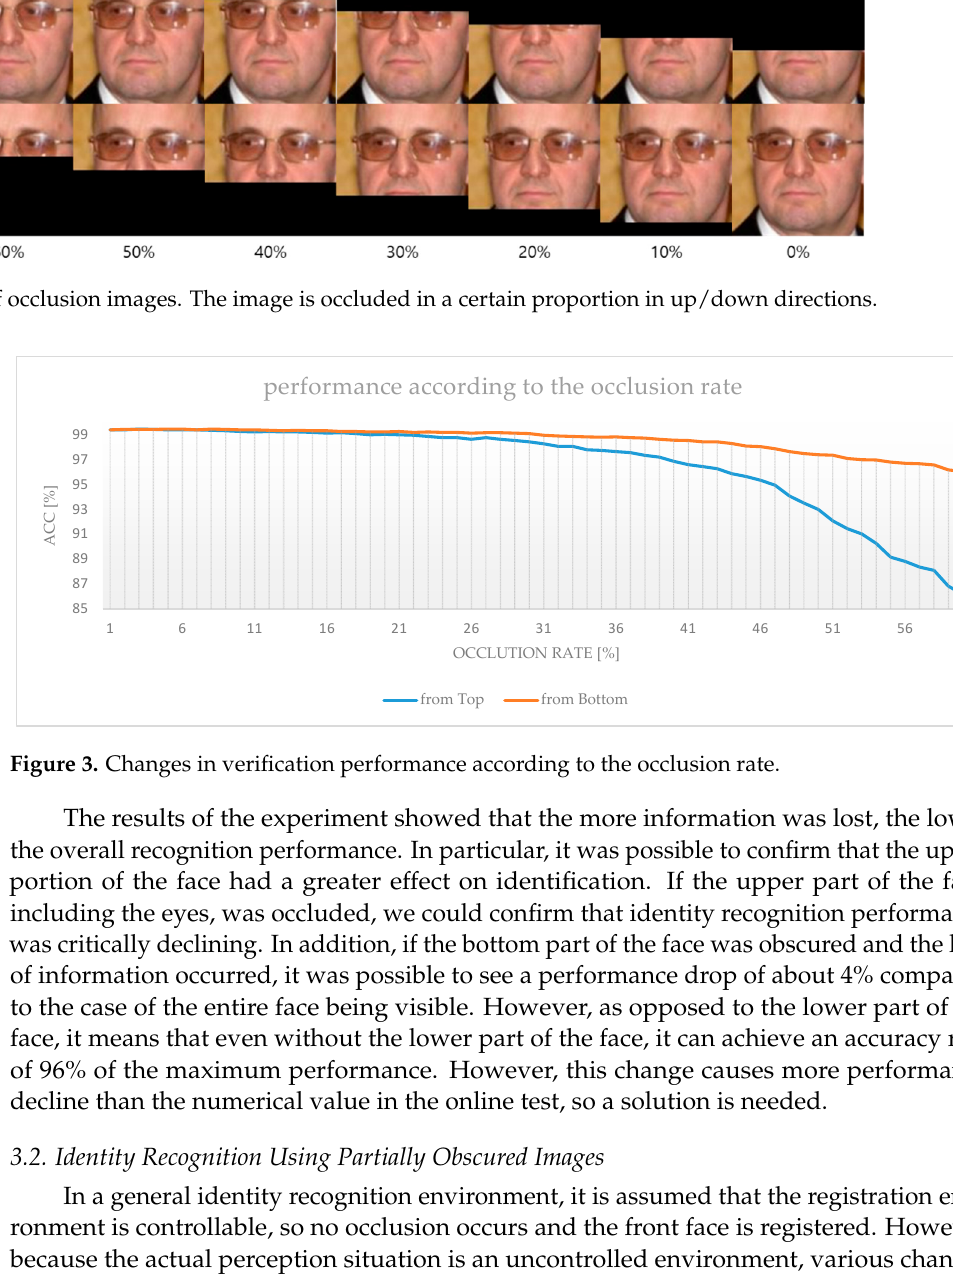
Figure 3. Changes in verification performance according to the occlusion rate.